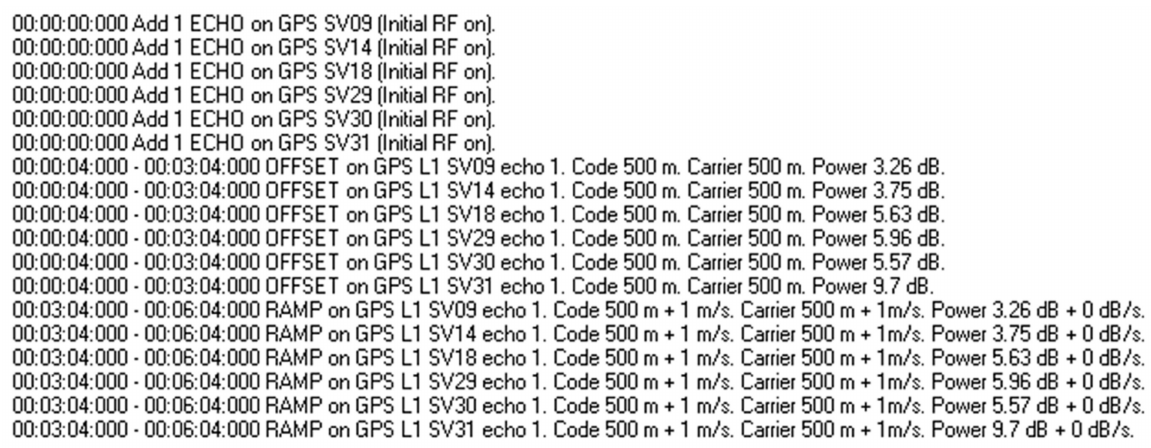
Figure 12. Experimental instruction design in experiment